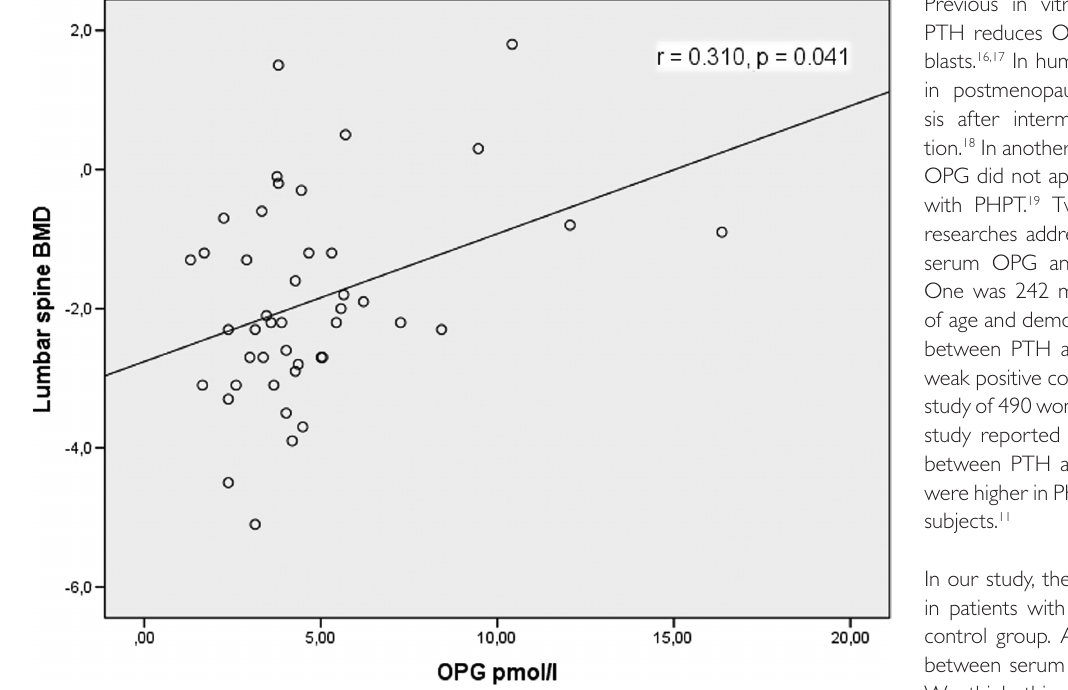
Figure 1. Correlation between lumbar spine BMD and OPG in PHPT patients. BMD, bone mineral density; OPG, osteoprotegerin; PHPT, primary hyperparathyroidism.